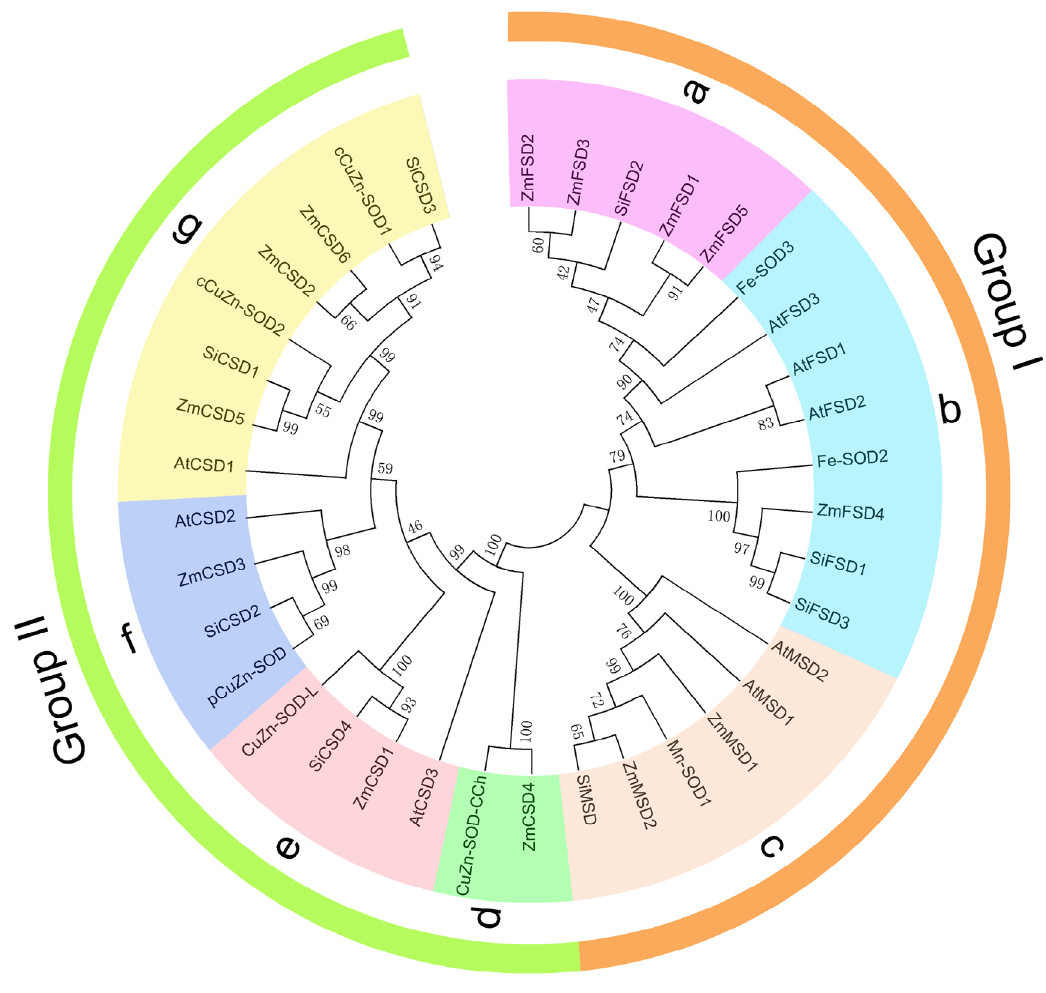
Figure 2 ‒ Phylogenetic relationships of 37 SOD proteins from different plant species.